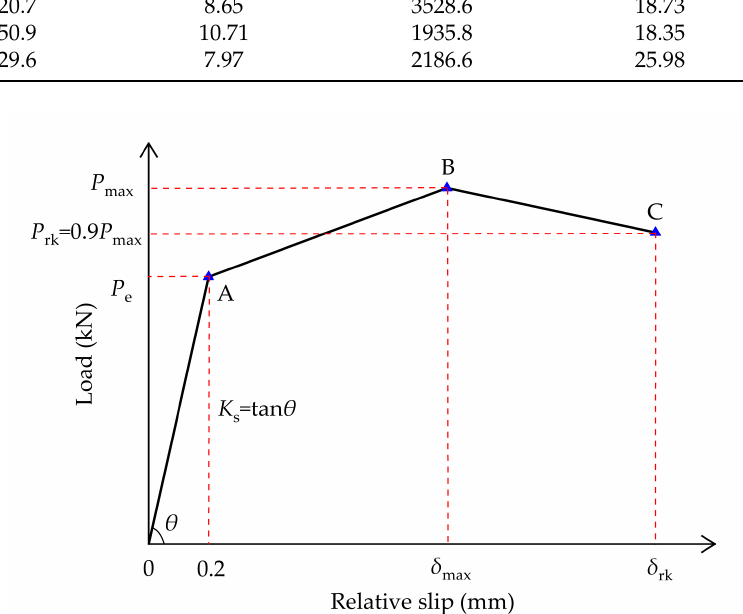
Figure 6. Definition of characteristic value for Load-slip